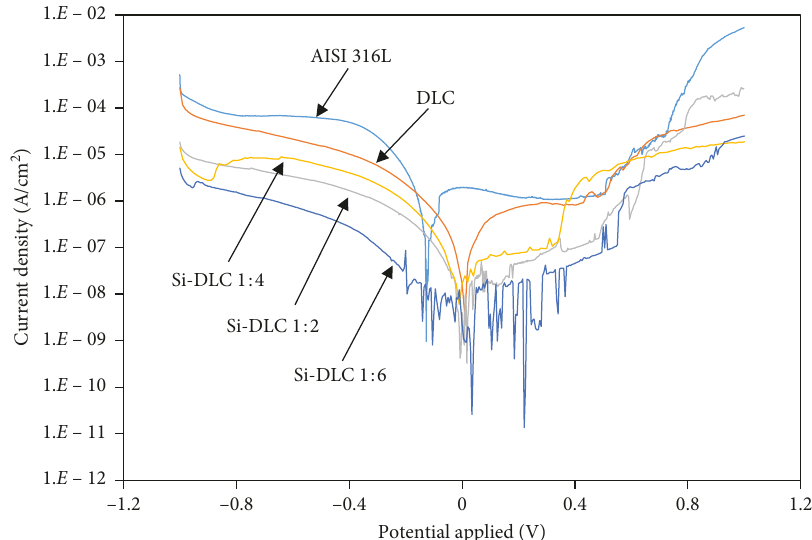
Figure 9: Potentiodynamic polarization curve of uncoated AISI 316L pure DLC and Si-DLC films.